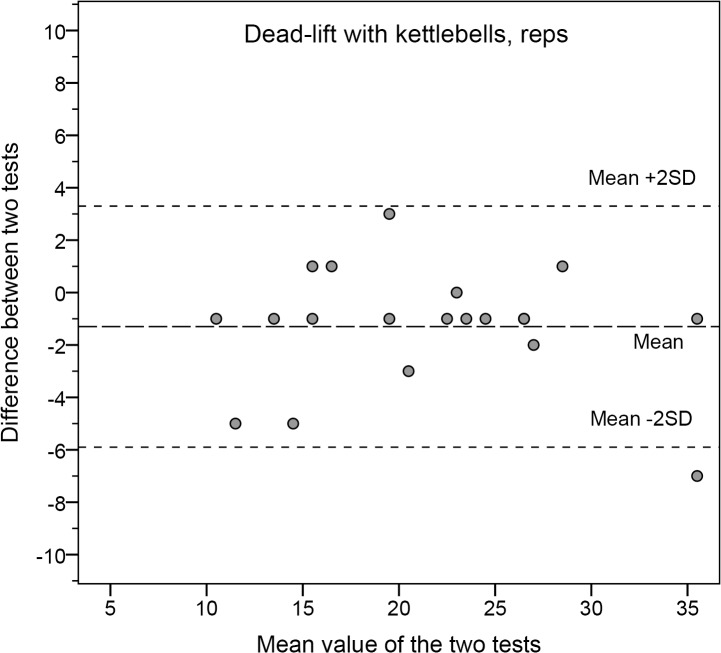
The differences between Test 1 and Test 2 for dead-lift with kettlebells.